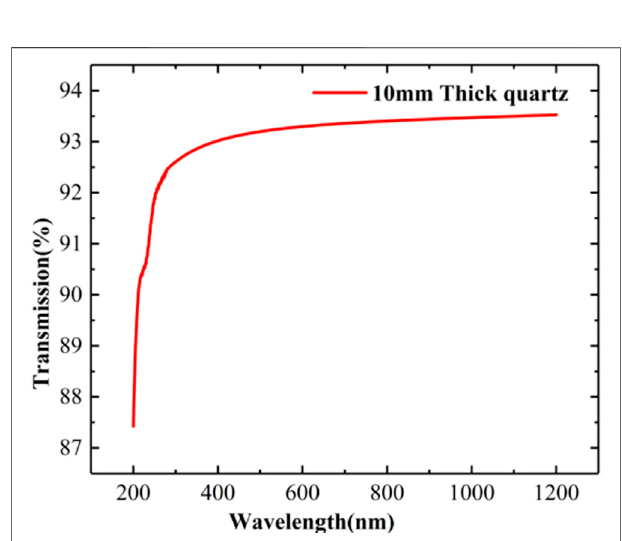
FIGURE 2 | Diagram of the transmittance curve of 10 mm thick quartz [26].